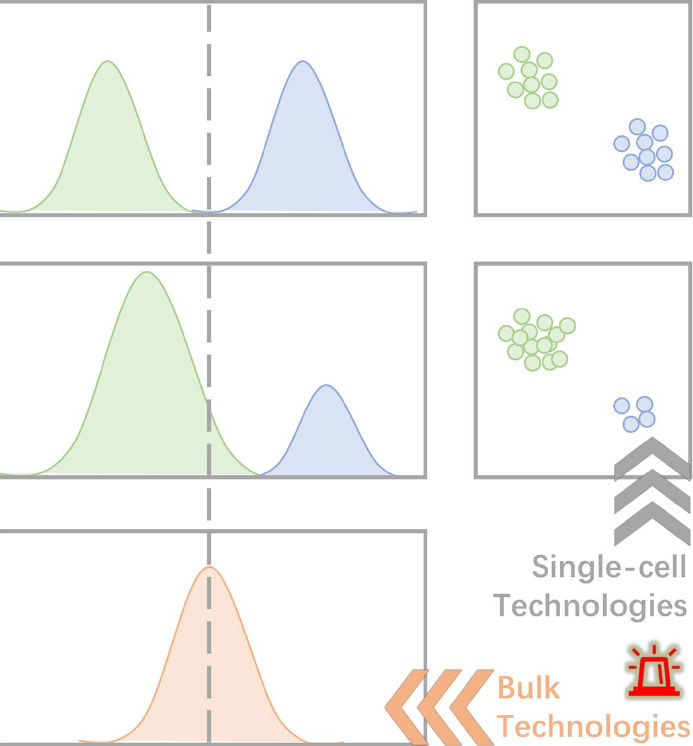
Figure 1. Comparison between bulk and single-cell techniques. Bulk analysis techniques provide average microbial information, while single-cell techniques provide more accurate microbial phenotypic heterogeneity.